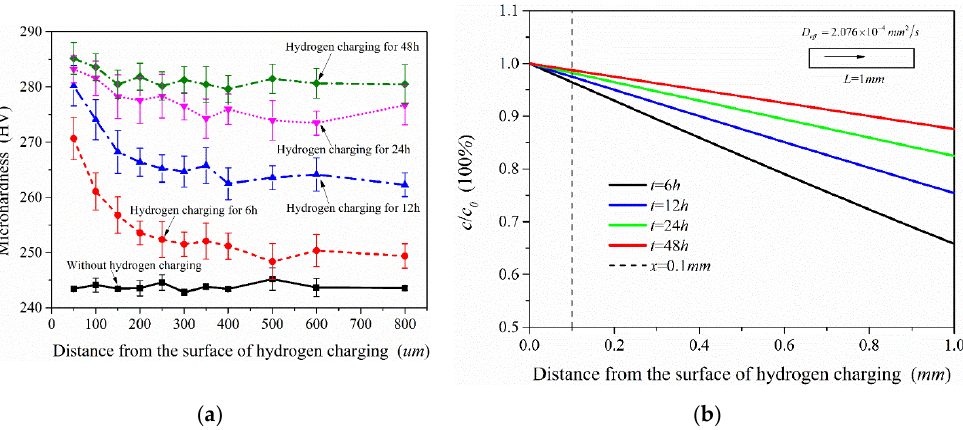
Figure 14. Microhardness test results of the samples under different hydrogen charging time ( a ) and diffusible hydrogen concentration distribution after charging ( b ).